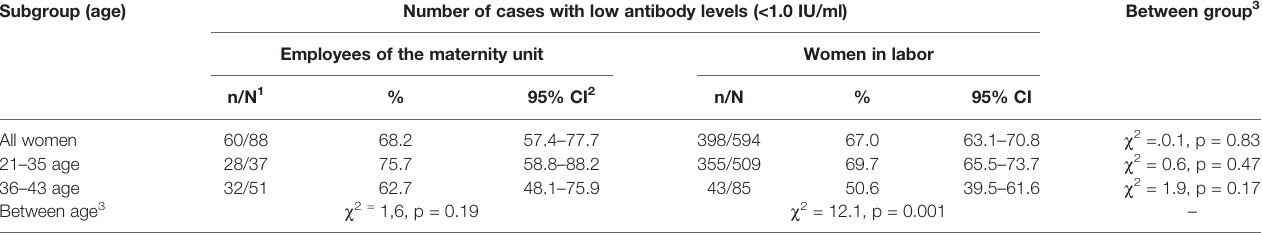
TABLE 2 | Comparison of the shares of cases with low antibody levels (<1.0 IU/ml) to the measles virus persons among the maternity unit employees and women in labor. Subgroup (age) Number of cases with low antibody levels (<1.0